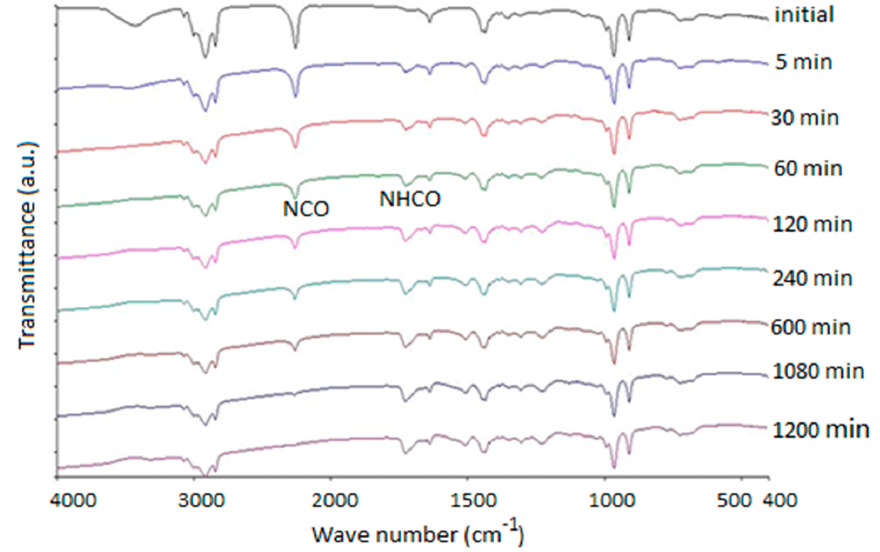
Figure 2. FT-IR spectra versus time of HTPB-IPDI reaction at 75 °C with TECH (0.1 wt %) as catalyst. From the spectra, one can find that, as the reaction proceeded, the intensity of the characteristic peaks around 2260 cm − 1 (NCO stretching) decreased and ultimately disappeared once the reaction